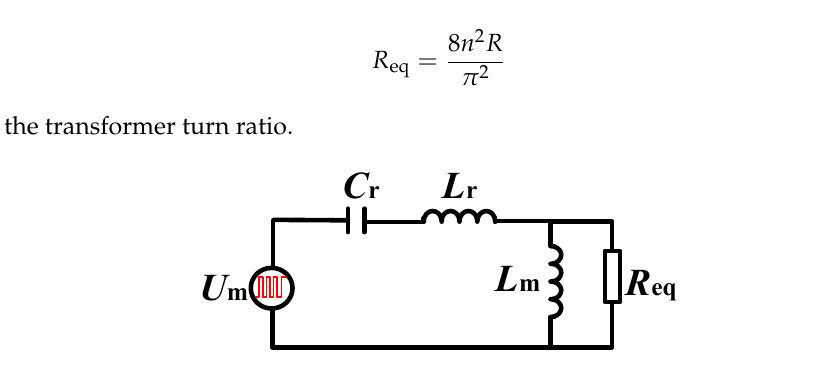
Figure 11. Equivalent circuit for the back-end LLC resonant converter.